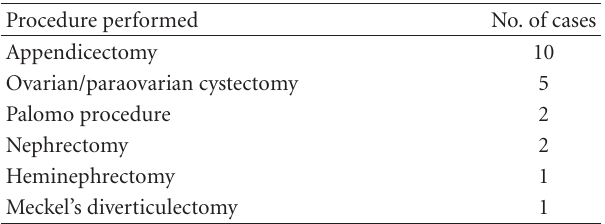
Table 1: Table showing the operative procedures performed over a one-year period using the technique described.